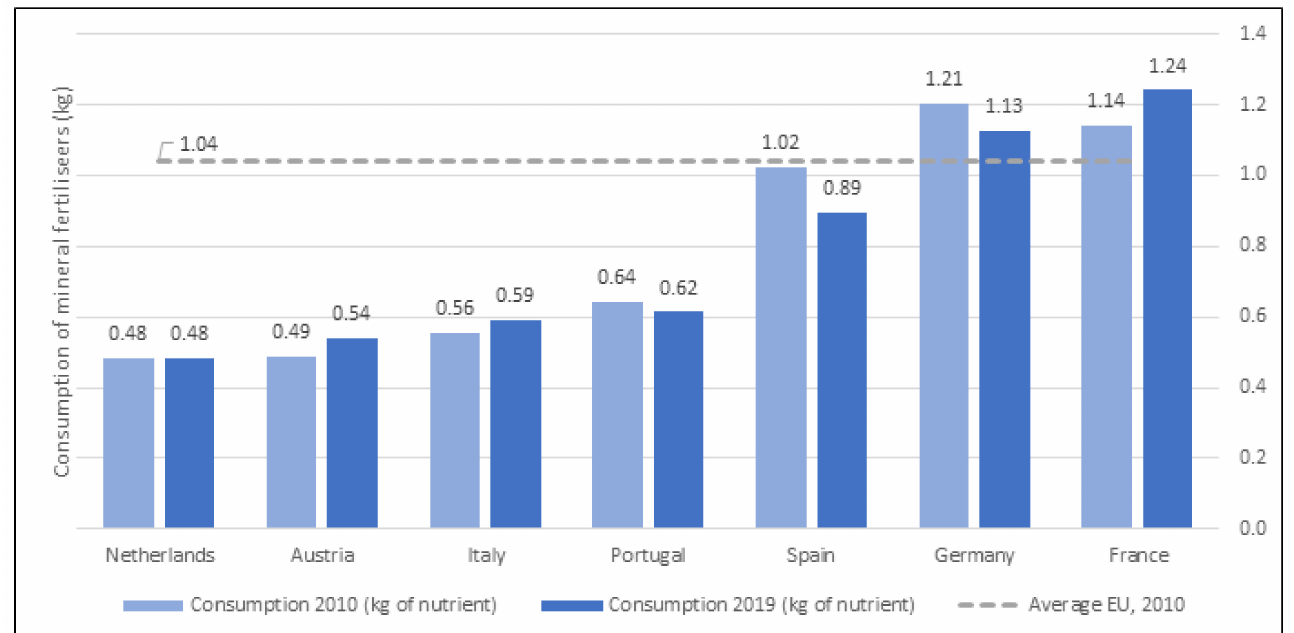
Figure 3. Consumption of mineral fertilisers per 1 kg of manure and other organic fertilisers. Source: own calculation based on Eurostat.